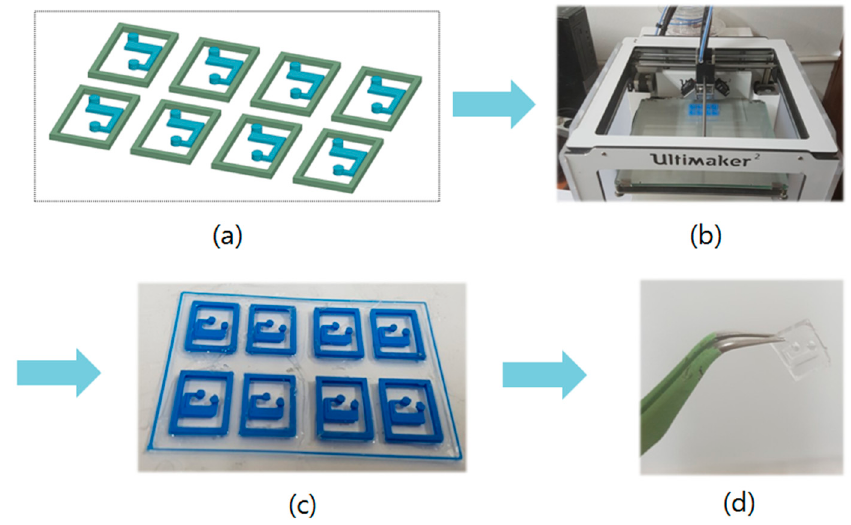
Figure 5. Process of fabricating the microfluidic channel: ( a ) design; ( b ) 3D printing; ( c ) PDMS solidification; and ( d ) the fabricated microfluidic channel.